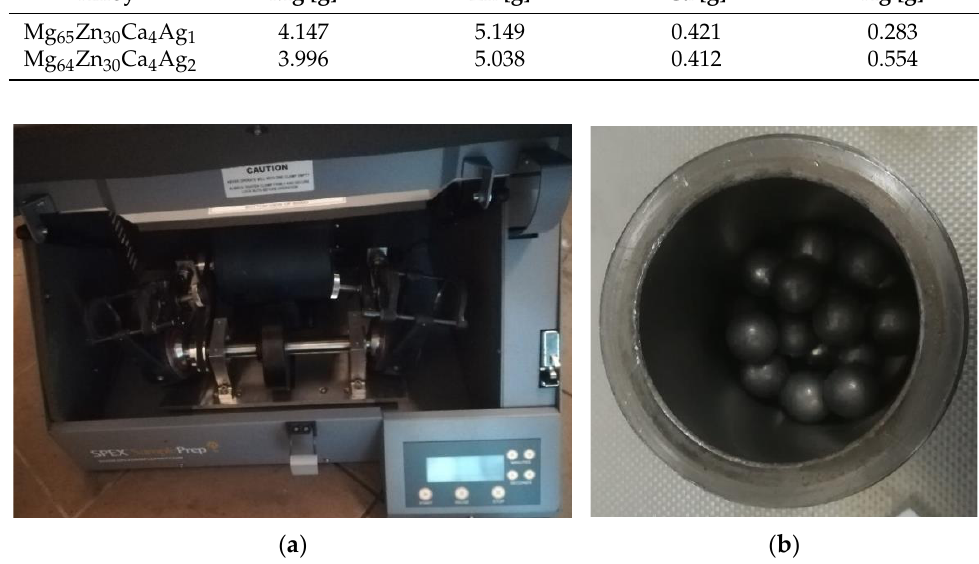
Figure 1. ( a ) High-energy ball mill type 8000D Mixer/Mill; ( b ) steel crucible containing steel balls.